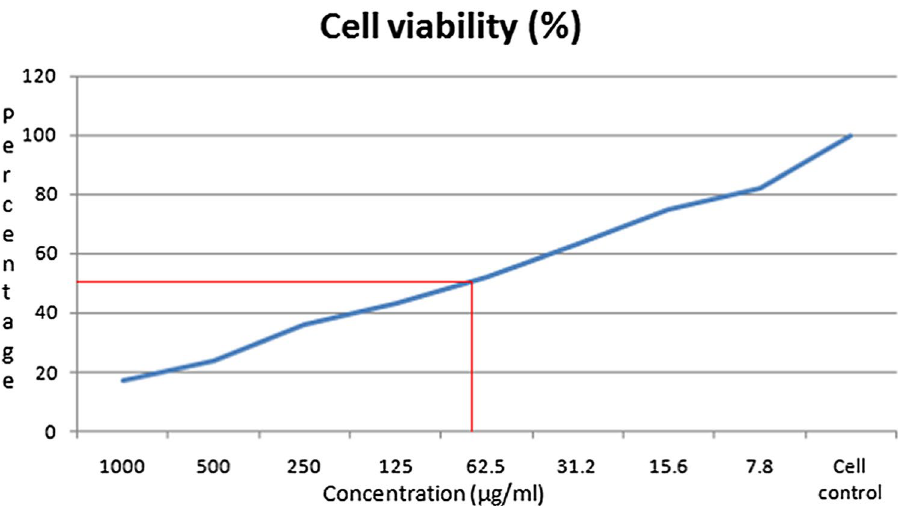
Figure 8. Percentage of inhibition in nanoparticles treated HeLa